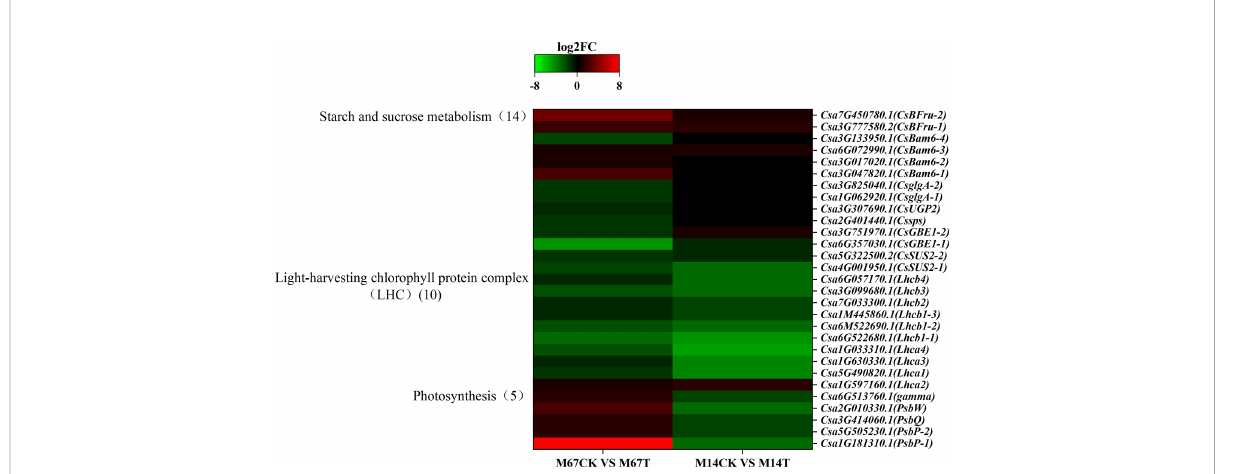
FIGURE 9 The Expression patterns of the differentially expressed genes (DEGs) induced by low-light stress in the pathway of starch and sucrose metabolism, LHC and photosynthesis. Expression change of the DEGs with at least twofold changes and p < 0.05 in this three pathways. The expression levels were calculated in fragment per kilobase per million reads (FPKM) from triplicate experiments. The heat map shows the normalized value Z-score after log2 (FPKM) transformation. The color in the heat map represents the Z-score after the transformation of log2 (mean FPKM). Each row in the heat map represents the levels of a DEG under different conditions. The DEG name and the gene ID in parenthesis were listed on the right side of the heat map.